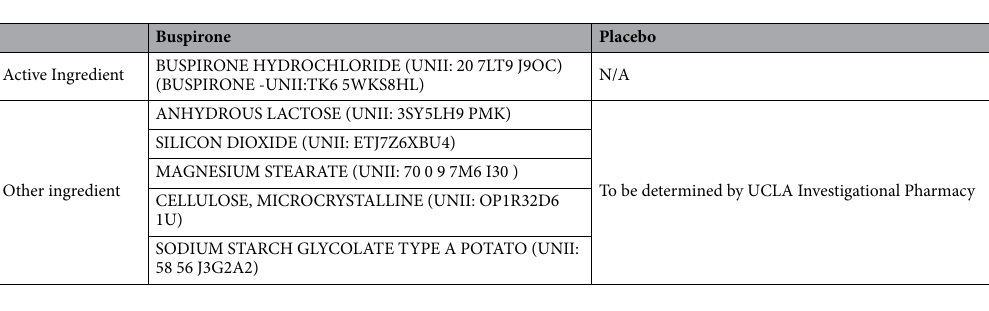
Table 2. Formulation of Buspirone and